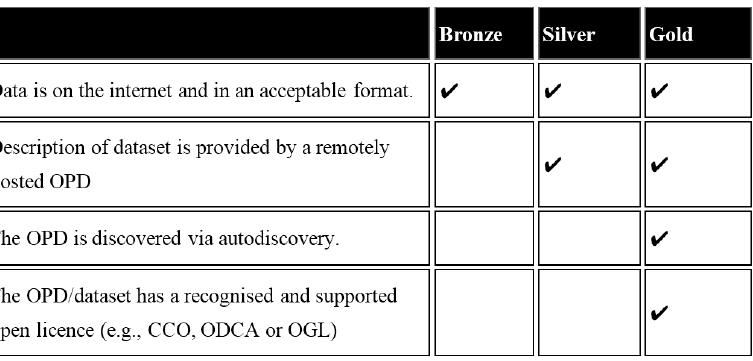
Figure 2. Compliance rating applied to data discovery.